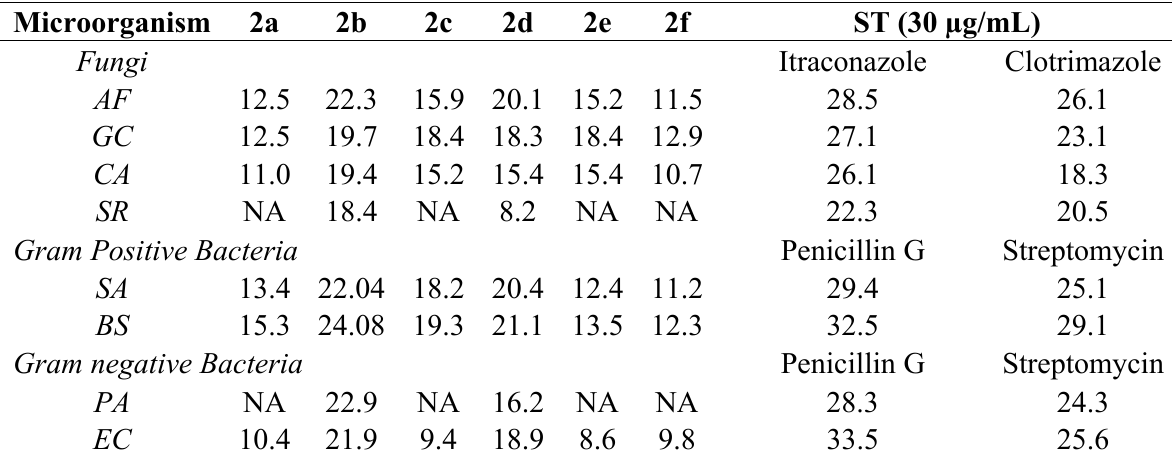
Table 1. Anti-microbial